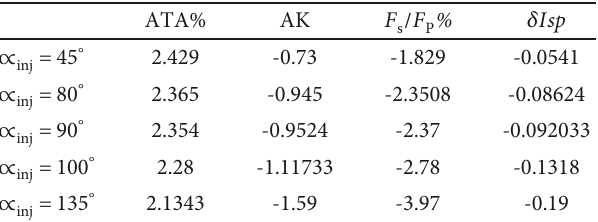
Table 8: SITVC performance parameters with respect to the injection angle at M = 2 75 . p